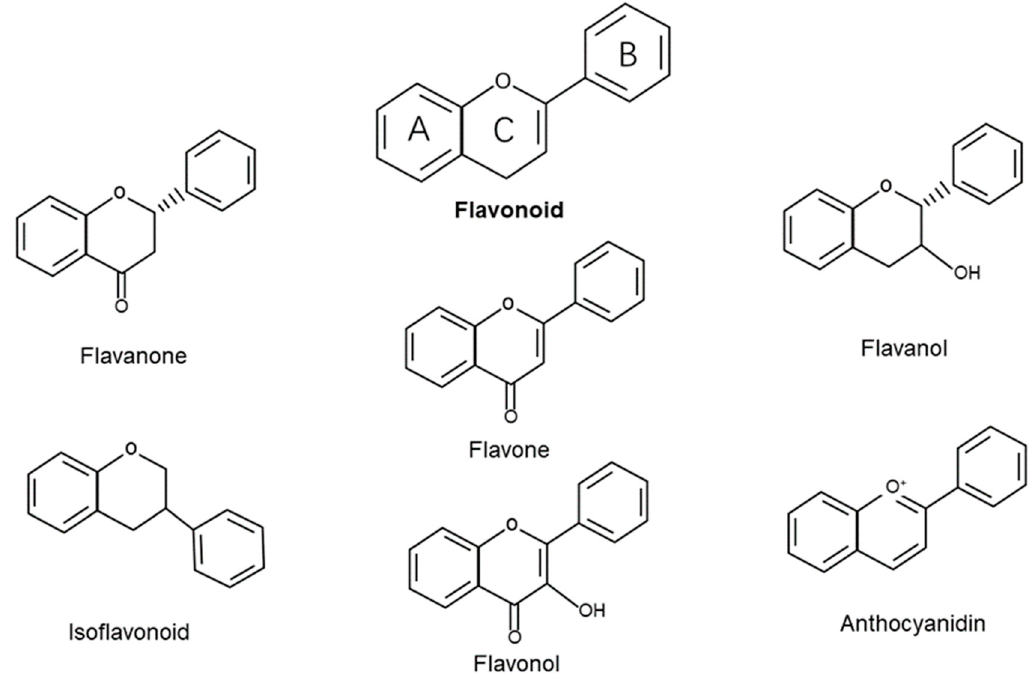
Figure 1. Chemical structures and classification of flavonoids.